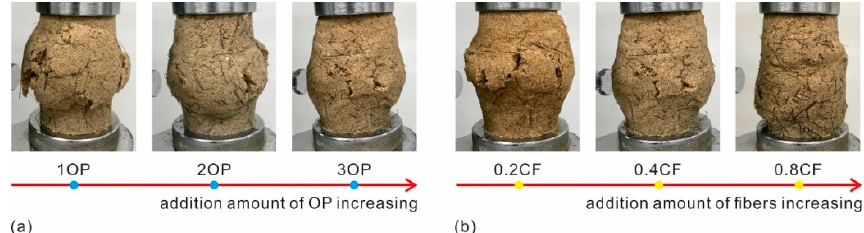
Figure 13. The failure pattern of OPCFRS with ( a ) 0.4CF and different OP contents. ( b ) 3OP and different CF contents.